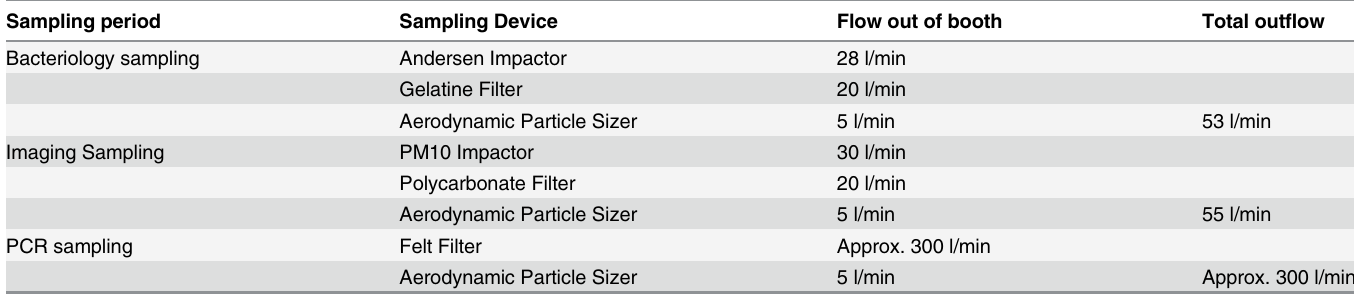
Table 1. Sampling rates of the capture devices and the periods in which they are